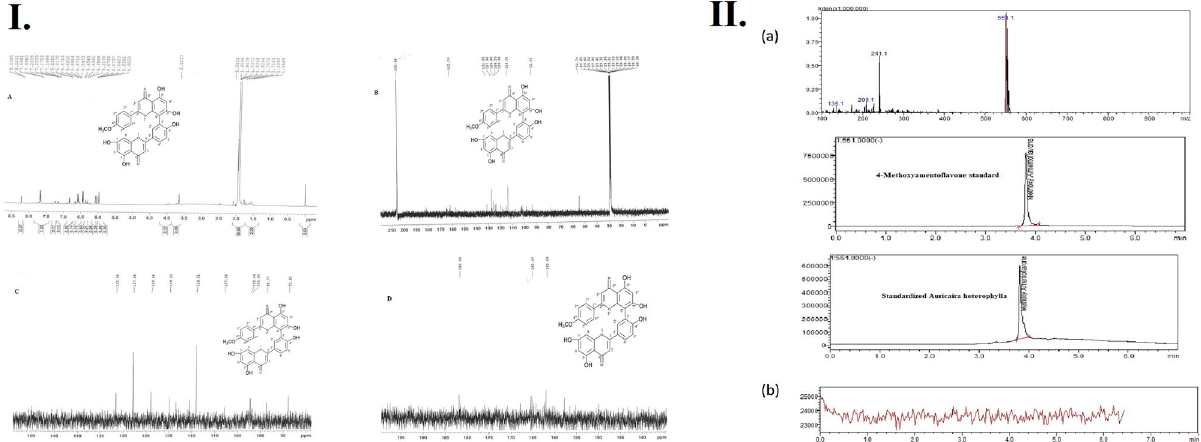
Figure 1. ( I ) Compound A 1 H NMR and 13 C NMR data, and ( II ) ( a ) Selected Ion Chromatograms, retention times, and full scan mass spectra (top), Selected Ion Chromatogram and retention time of 4 ʹʹʹ methoxyamentoflavone standard (middle) and Selected Ion Chromatogram and retention time of SAH (bottom), and ( b ) Blank samples appeared free from any interfering substances at the retention time and m/z of the studied